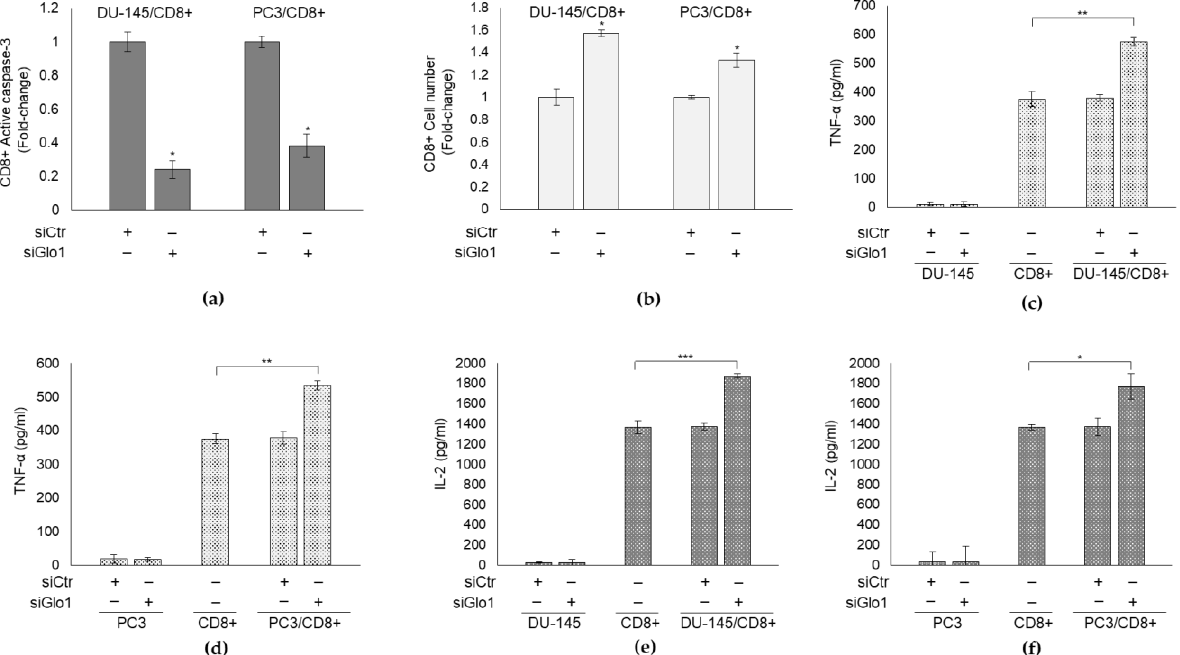
Figure 5. Glyoxalase 1 (Glo1) is involved in mPCa immunosurveillance escape. DU145 and PC3 cells transiently transfected with Glo1 small interfering RNA (siGlo1) or control non-targeting small interfering RNA (siCtr) were co-cultured with CD8+ cytotoxic T cells and ( a ) CD8+ apoptosis was evaluated by active caspase-3 expression, with a specific ELISA kit, ( b ) CD8+ cell number was measured by cell counting, ( c , d ) TNF-α and ( e , f ) IL-2 secretion by CD8+ cells in the culture medium was detected by specific ELISA kit. The histograms indicate mean ± SD of three different cultures, and each was tested in duplicate. (−) untreated and (+) treated cells. * p < 0.05, ** p < 0.01; *** p 0.001.